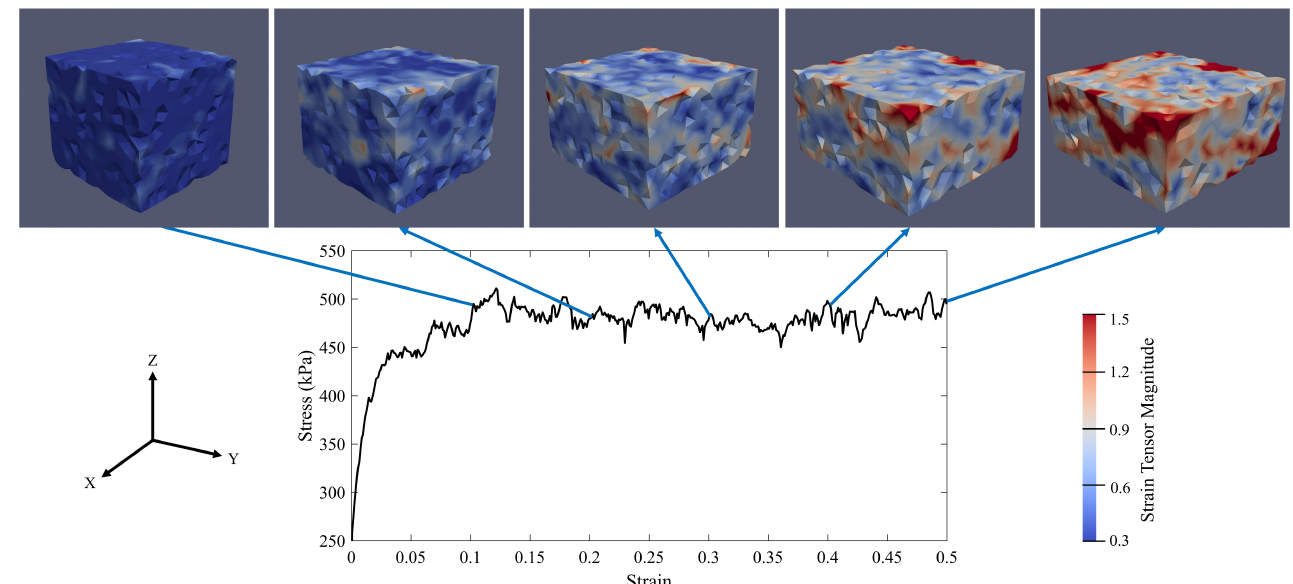
Figure 17. The evolution of micro-strain of specimen S 2 during the compaction process according to its stress-strain diagram